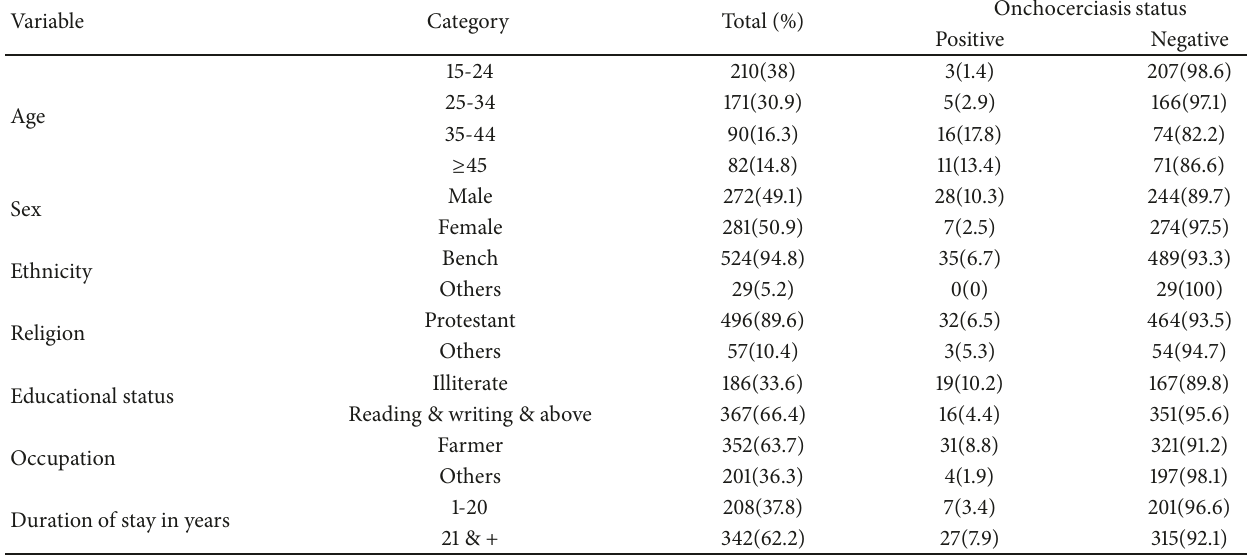
Table 1: Sociodemographic characteristics of study participants in Semen Bench district, Bench Maji zone, Southwest Ethiopia, June 2018